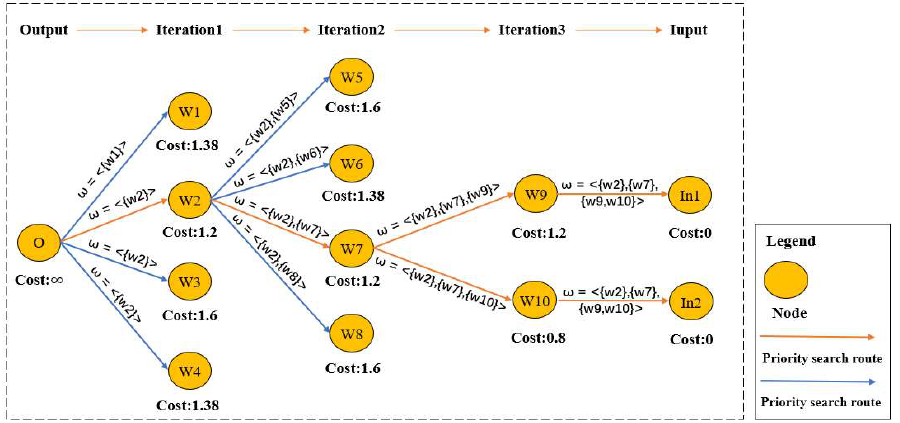
Figure 5. A simple example of the composition